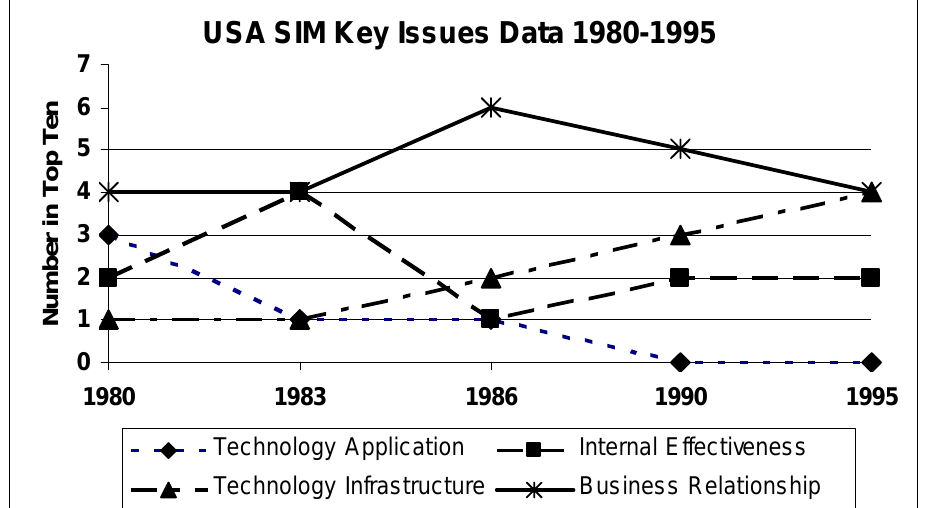
Figure 1: Changes in USA SIM categories 1980 – 1995 (Hart,